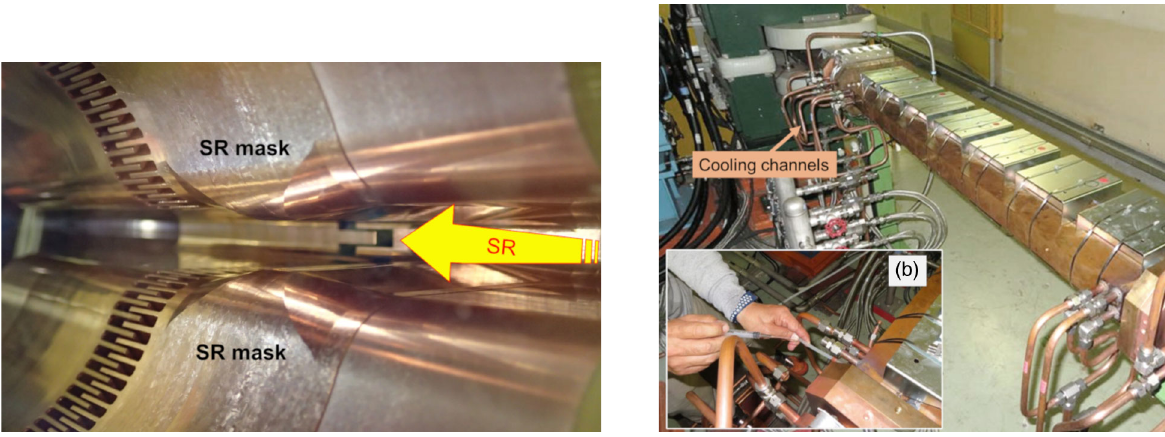
FIG. 31. Inside of a bellows chamber with SR masks at antechambers developed for wiggler sections.